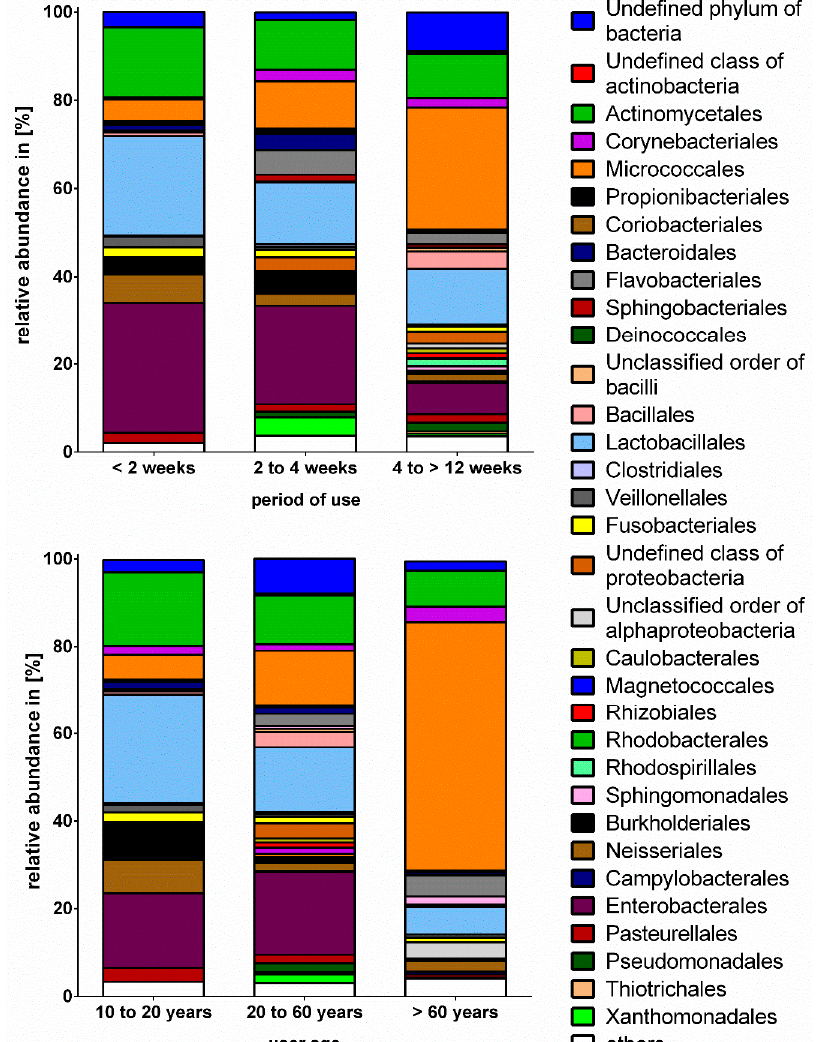
Figure 3. Taxonomic composition on order-level for all analysed toothbrushes grouped by period of use (< 2 weeks ( n = 6), 2–4 weeks ( n = 6), 4–>12 weeks ( n = 11)) and user age (10–20 years ( n = 5), 20–60 years ( n = 14), > 60 years ( n = 4)) based on NGS. For samples TB6 and TB7, the generation of amplicons failed and therefore these samples were not sequenced. Due to better presentation, only results ≥ 1% are given. Table 3. Percentage of bacterial orders based on period of use and age of the users. Significantly higher fractions are marked with a * based on non-parametric Mann-Whitney test ( p ≤ 0.05).